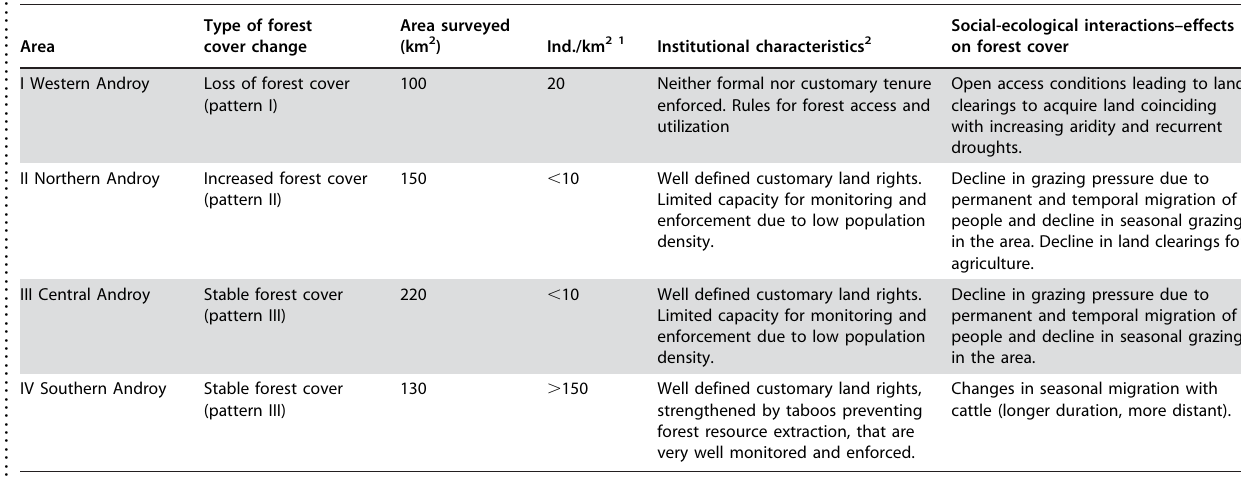
Table 2. Institutional characteristics of the four surveyed areas. .. ... .... ... ... .... ... ... .... ... ... .... ... ... .... ... ... .... ... ... .... ... ... .... ... ... .... ... ... .... ... ... .... ... ... .... ... ... .... ... ... .... ... ... .